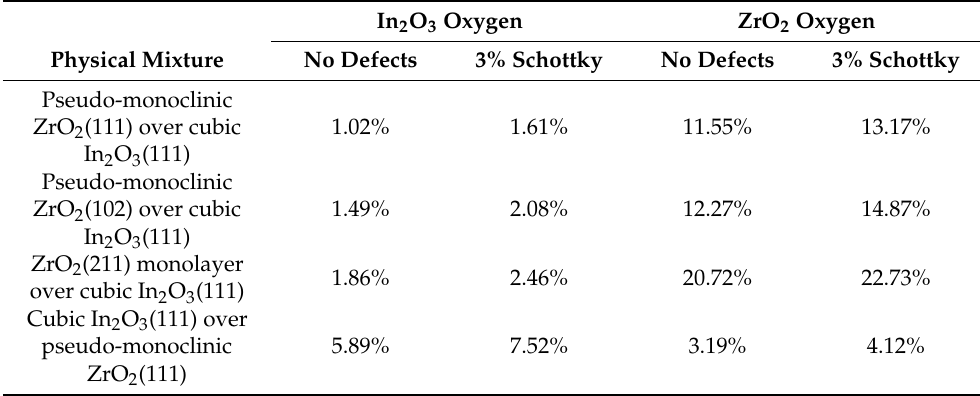
Table 9. Anion Frenkel defects formation percentage at 850 ◦ C in physical mixtures.